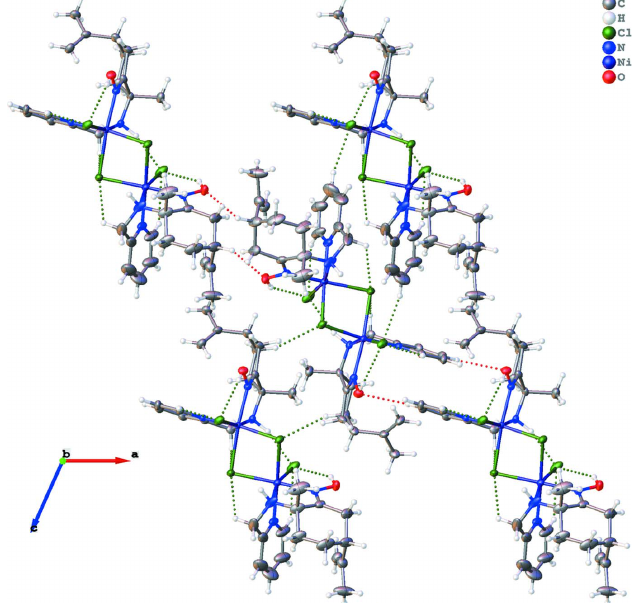
Figure 1 Displacement ellipsoid plot at the 50% probability level for Ni 2 (amino- oxime) 2 Cl 4 . H atoms are omitted for clarity.